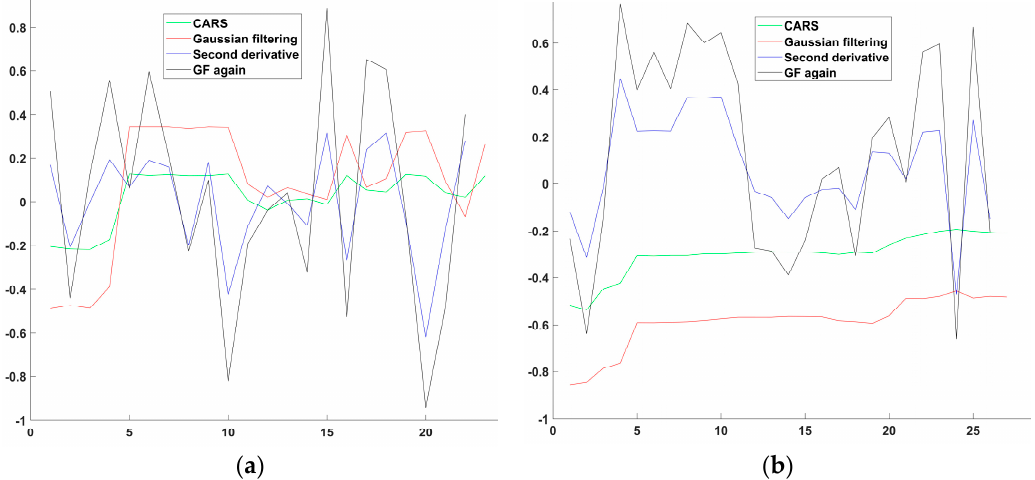
Figure 7. Variation of the correlation coefficient after the different pretreatments. ( a ) Honghu; ( b ) Daye.